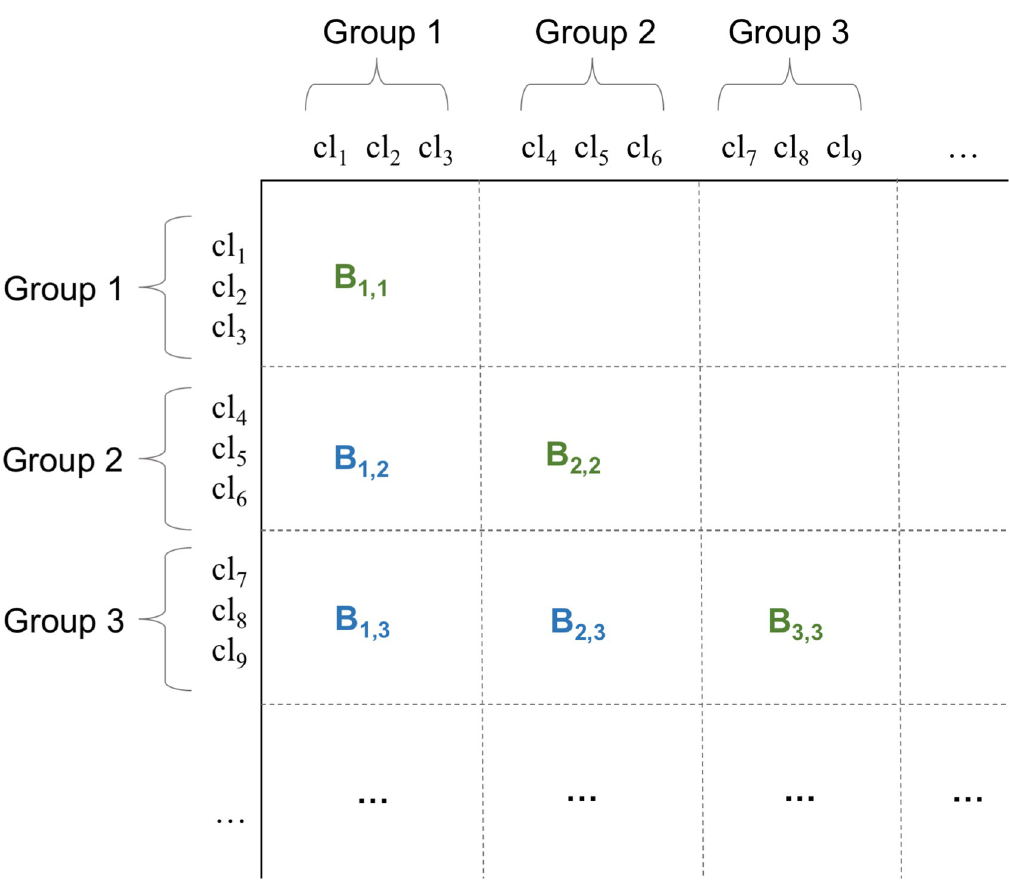
Fig 2. Schematic representation of the primary clusters’ distance matrix organised into blocks. The cluster list is first split into N groups of equal size and then the distance matrix is divided into N 2 blocks with each block containing distances between clusters in two groups. Since the matrix is symmetric, we can consider a single block for each pair of groups. Blue blocks represent off-diagonal blocks, green blocks represent diagonal blocks.